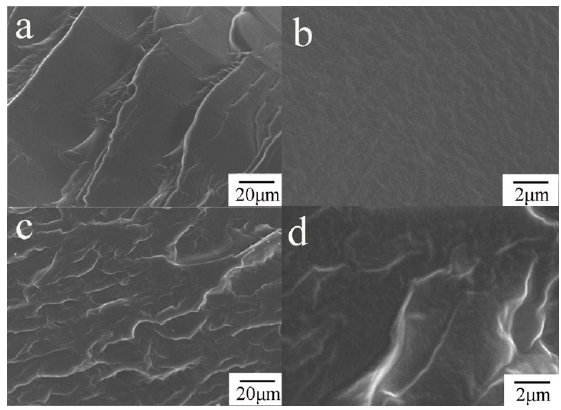
Figure 7. Field emission scanning electron microscopy (FESEM) images of LCPU ( a , b ) and LCPU5 ( c , d ).